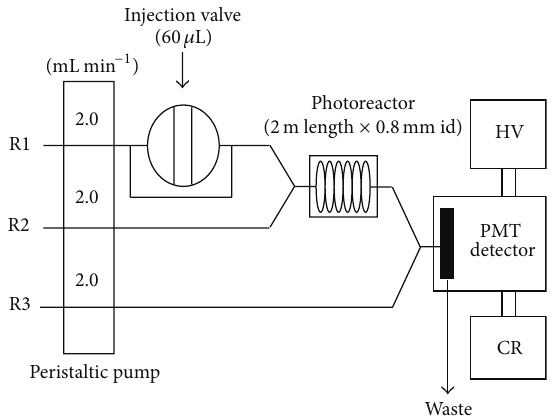
Figure 1: FI-CL manifold for the determination of retinol. R1 = pyrophosphate buffer (0.01M, pH 10.25), R2 = RB (1 × 10 −4 M) containing Cu 2+ (5 × 10 −4 M), R3 = luminol solution (5 × 10 −5 M), CR = chart recorder, HV = high voltage power supply, and PMT = photomultiplier tube